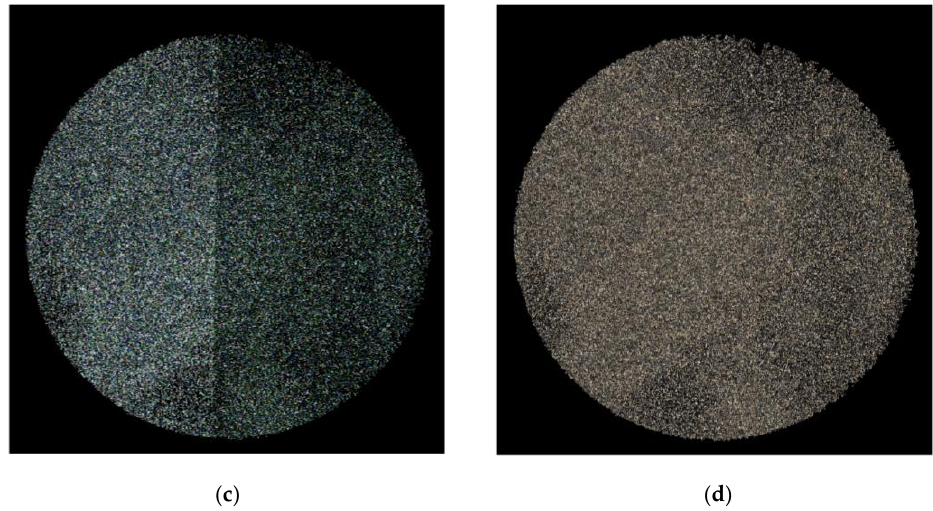
Figure 3. Outcome of the preprocessing steps. Images show the original SEM images ( a ), the outliers removed using the morphological and contours-based method from the binary converted image ( b ), the preprocessed outcome SEM image after removing outliers ( c ), and the preprocessed outcome of the original image after removing outliers ( d ). Wrong format.